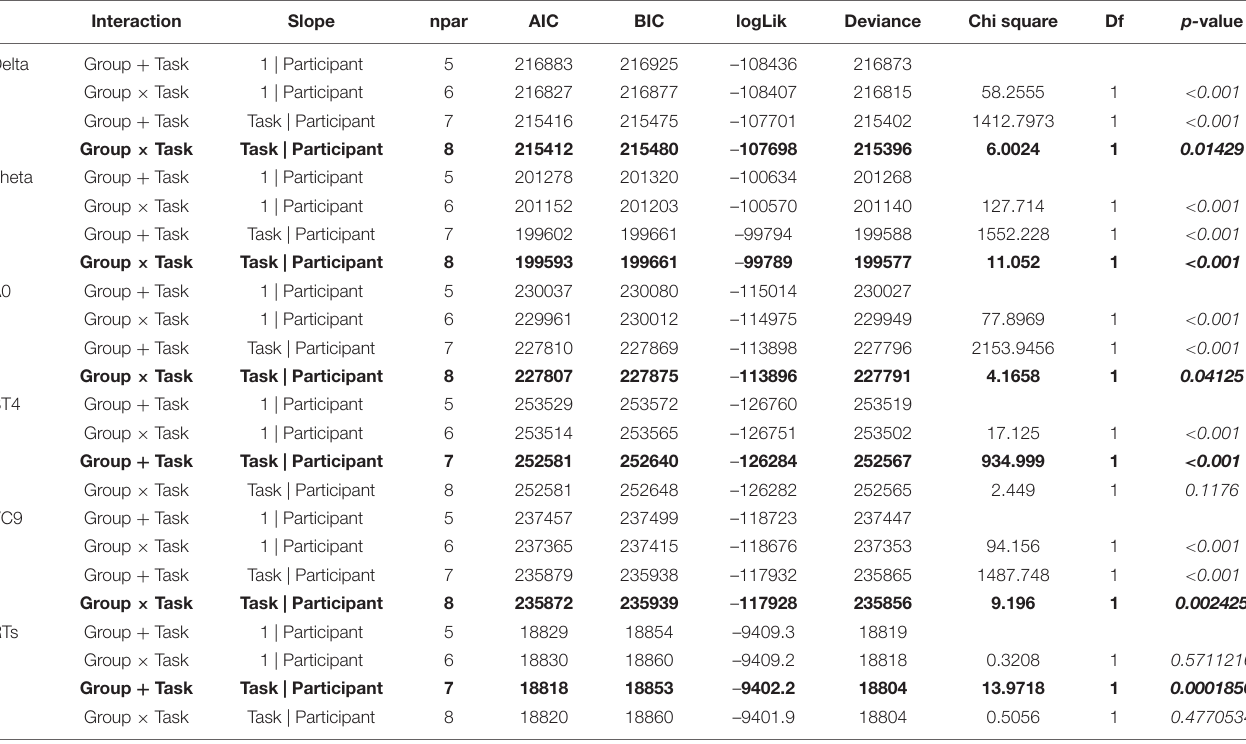
TABLE 4 | Model type, number of parameters, AIC, BIC, loglik, deviance, Chi square, df and p -values of GLMM models selection for each of the EEG features. Interaction Slope